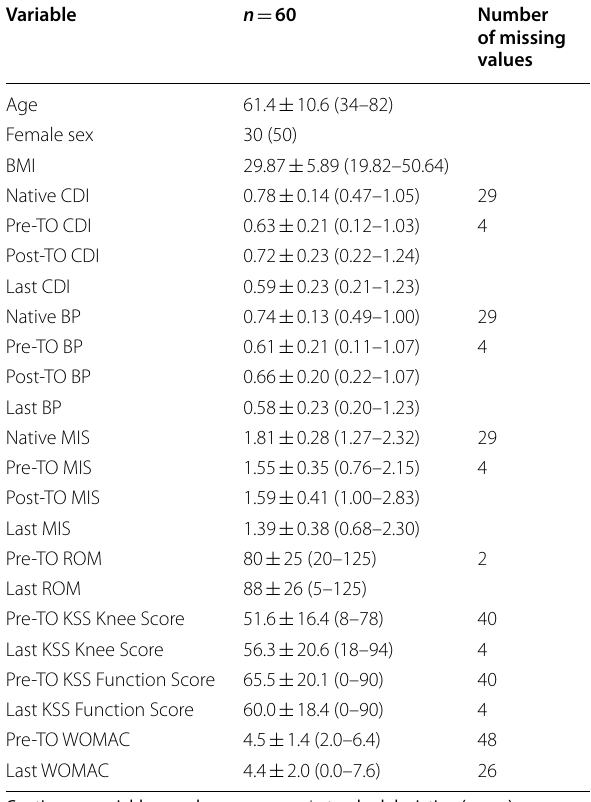
Table 1 Demographic data of the study